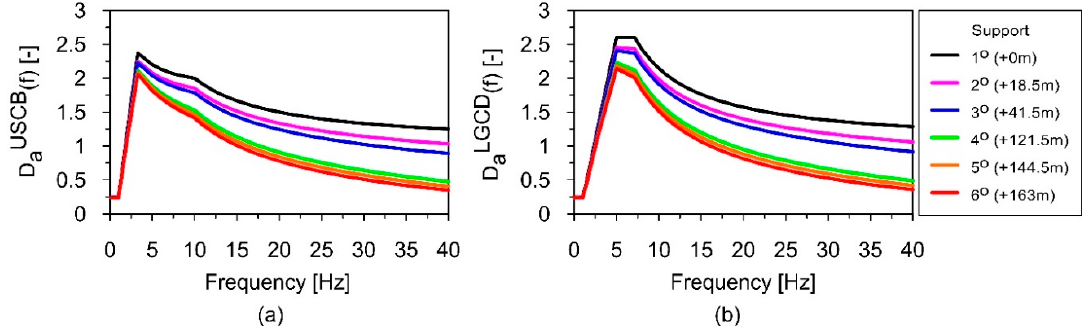
Figure 14. The response spectrum functions used in MSRS analysis for: ( a ) the USCB; ( b ) the LGCD region.